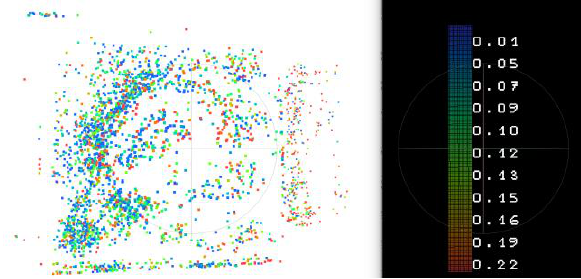
Figure 6. 3D model representing the residuals of the tie-points relative to the calibration and relative orientation performed using the Brown’s model.